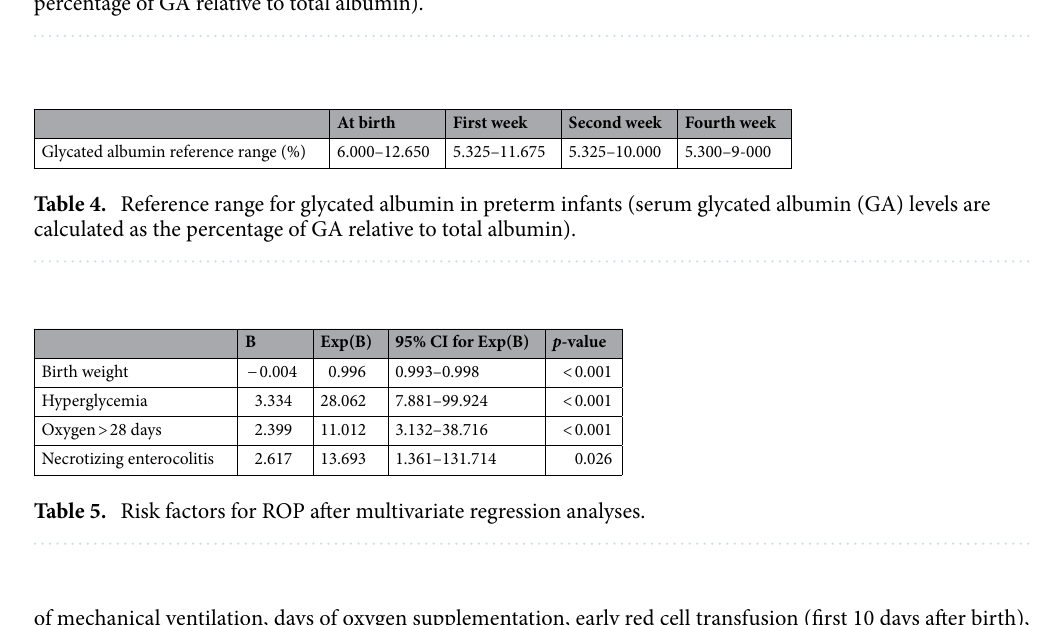
Table 3. Summary of glycated albumin values (serum glycated albumin (GA) levels are calculated as the percentage of GA relative to total albumin).